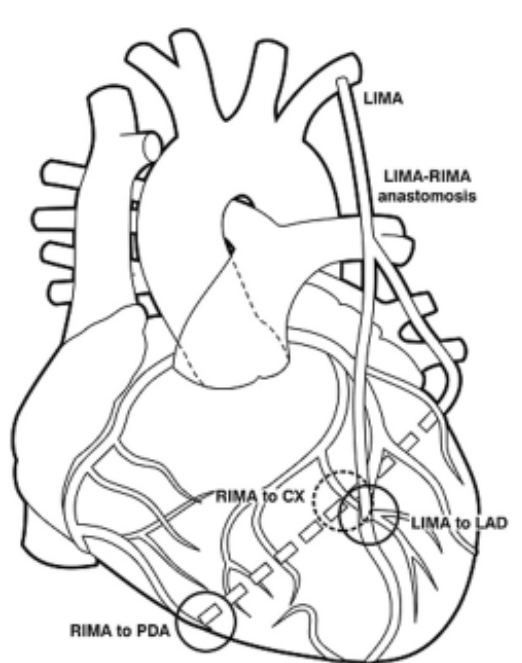
Fig. 1 - Técnica de revascularização arterial exclusiva mais freqüentemente utilizada. LIMA: artéria torácica interna esquerda, RIMA: artéria torácica interna